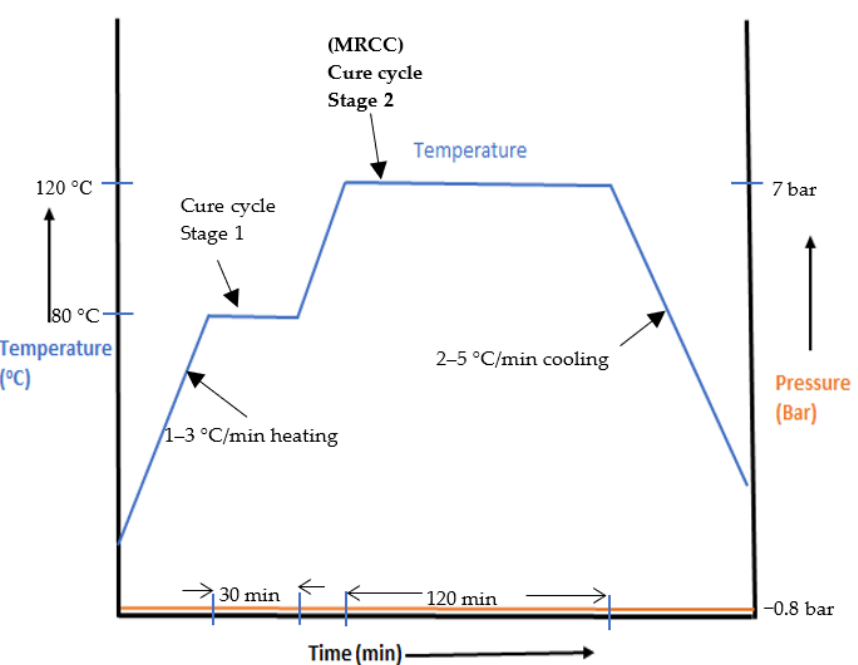
Figure 1. Manufacturer-recommended curing cycle (MRCC) comprising T c = 120 ◦ C, t c = 120 min, and P au = 7 bar.